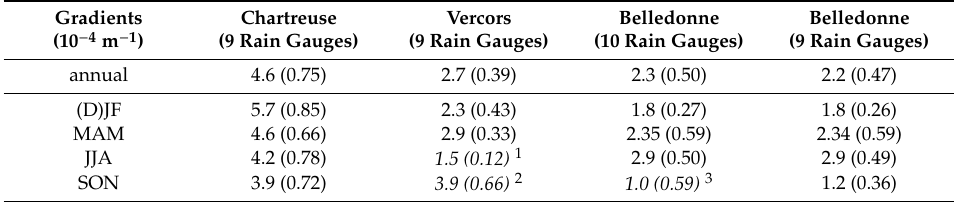
Table 1. Annual and seasonal relative altitudinal gradient estimates (and corresponding R 2 values).